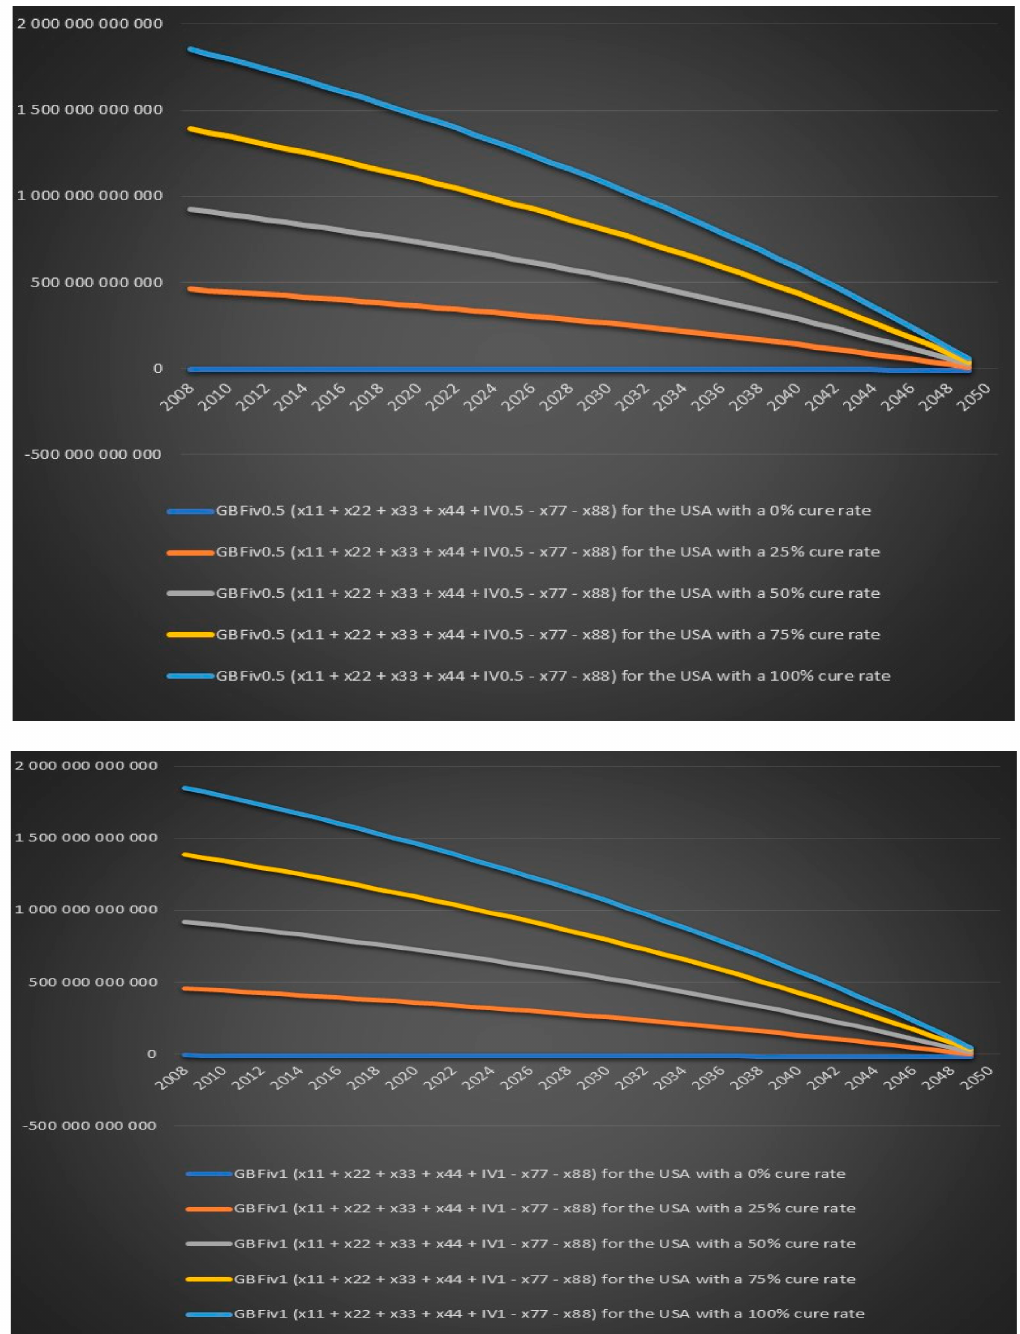
Figure 21. Today’s government costs and revenues in Europe over